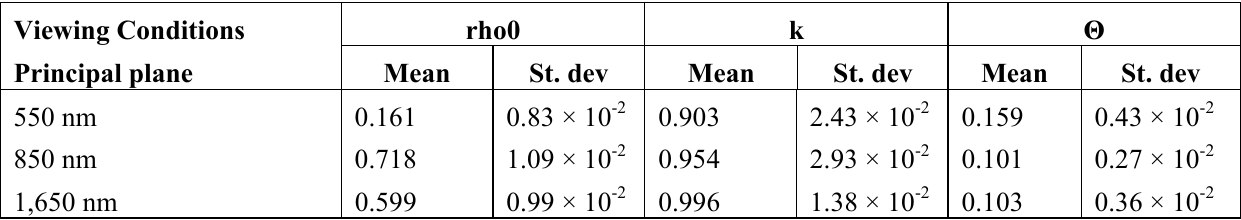
Table 1. Mean and Standard Deviations (St. dev) of the RPV model parameters as retrieved by the inversion for three wavelengths (550 nm, 850 nm, and 1,650 nm) at zenith light source of 45°.